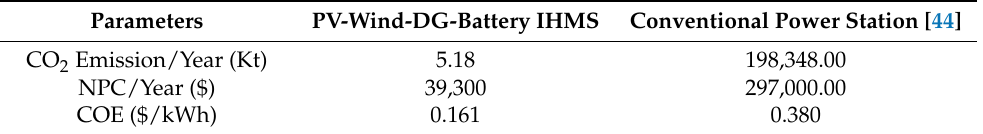
Table 3. Comparison of CO 2 emission, NPC, COE, and operating cost between the IHMS and Conventional Power